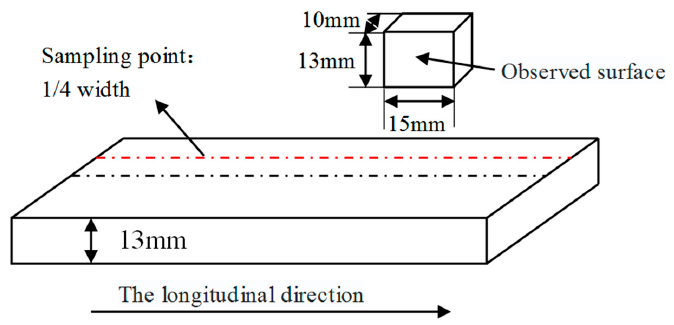
Figure 2. Schematic diagram of sampling in rolled metal.